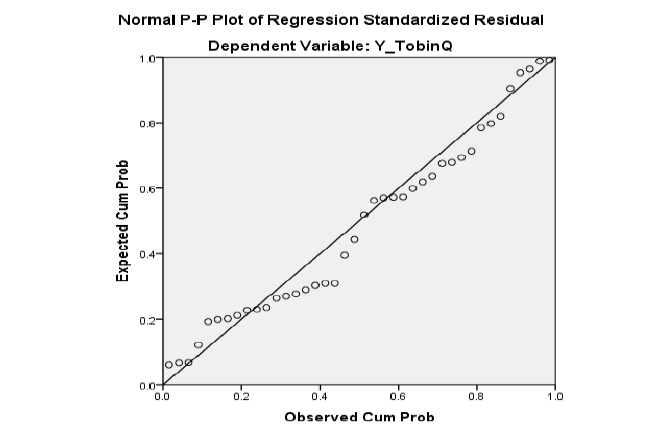
Figure 1: Normal P-P Plot of Regresion Standarized